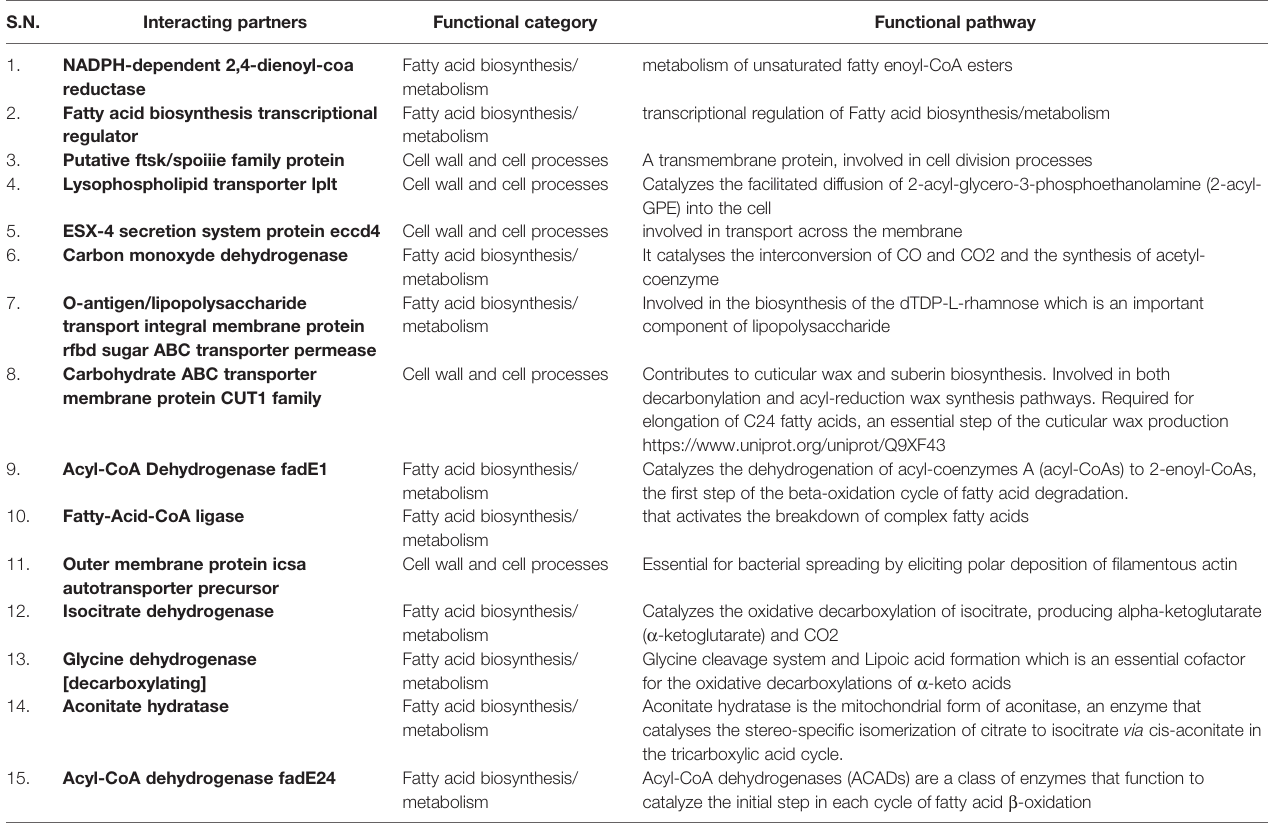
TABLE 1 | List of possible interacting ligands, the functional category of each and a summary of the functional pathway or reaction catalyzed.